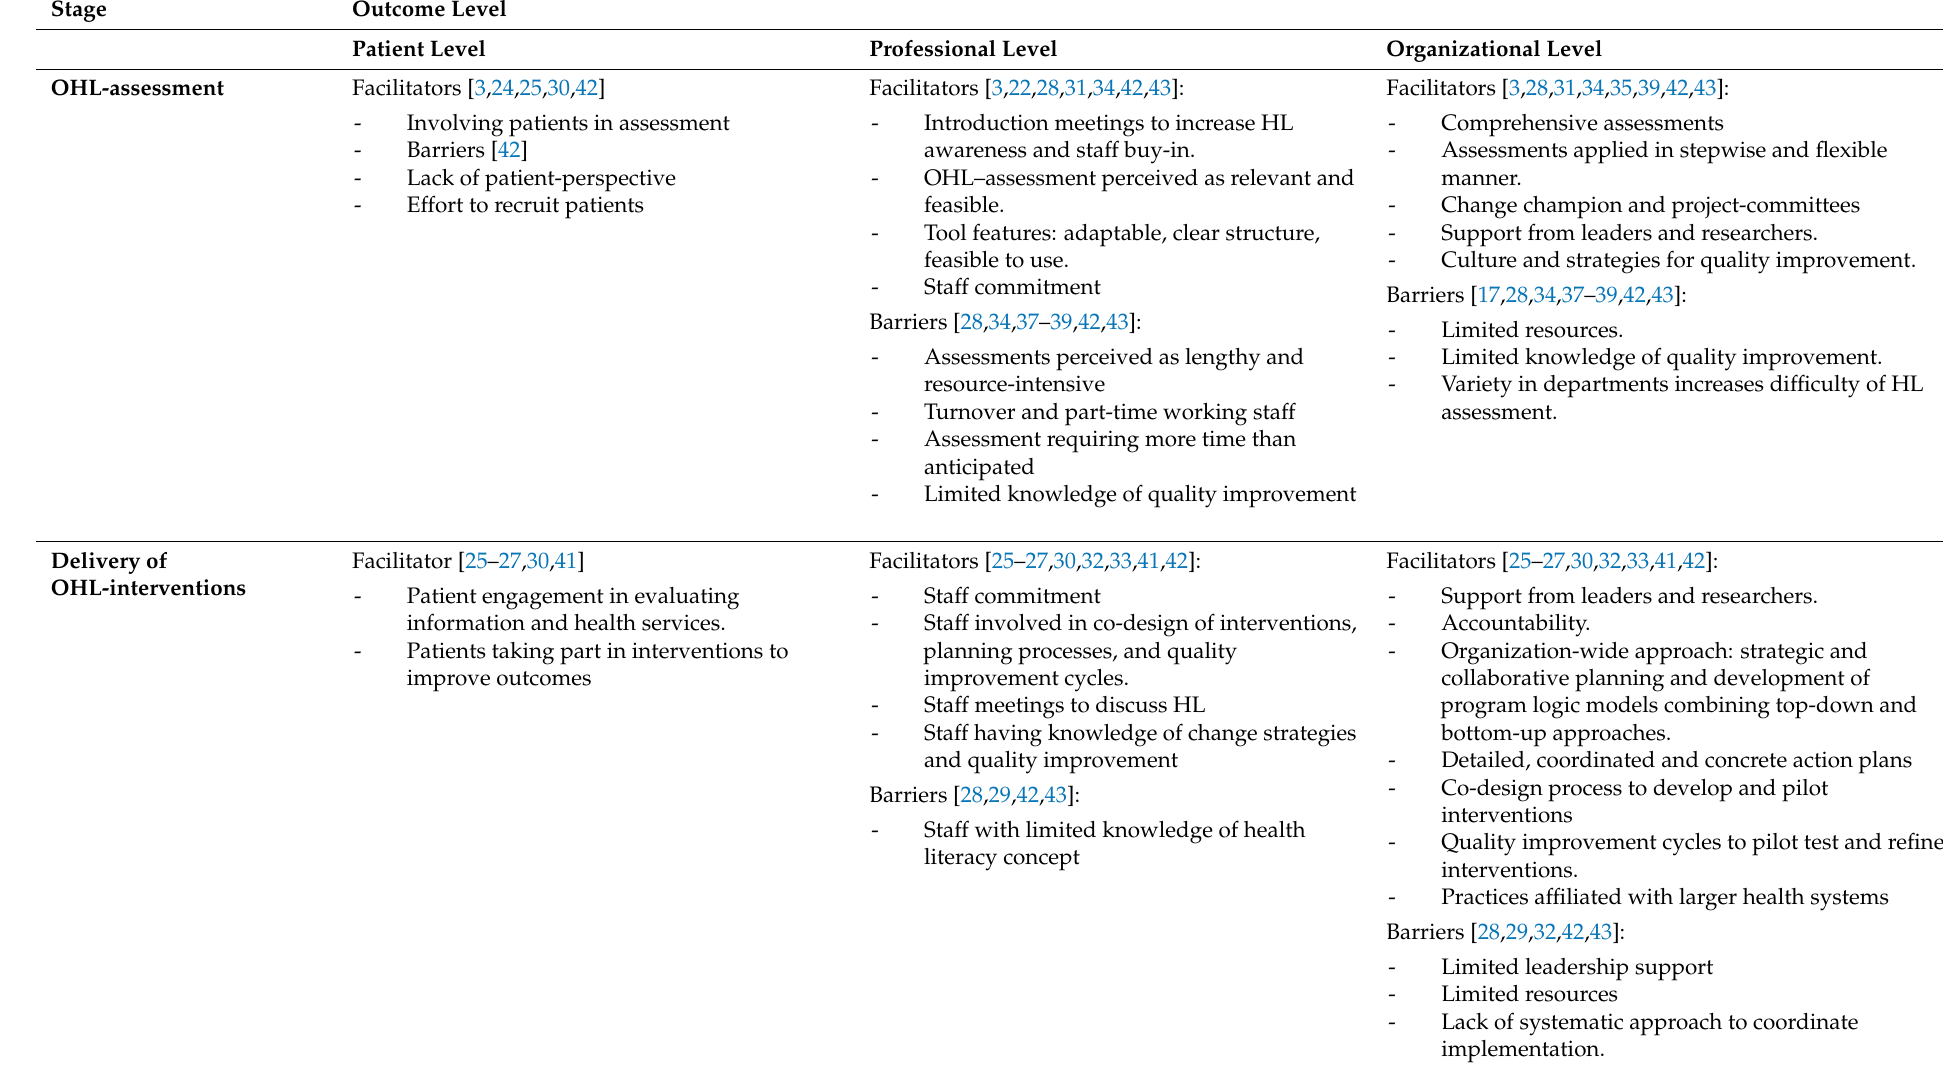
Table 3. Factors and strategies influencing assessment and delivery of